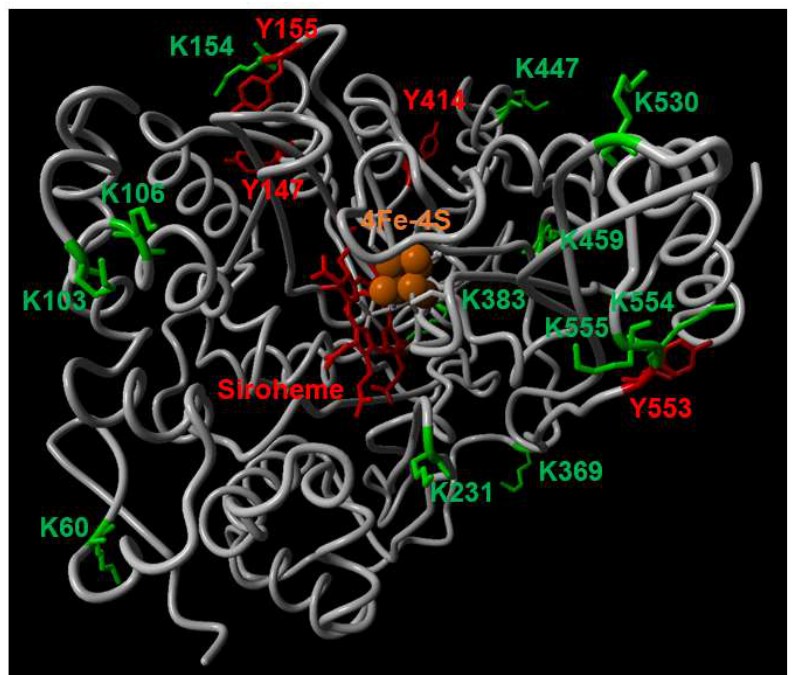
Figure 4. Location of identified PTMs in the 3D structure model of Spinacia oleracea NiR. Nitrated Y residues (red) and ubiquitylated K residues (green) location in the 3D structure of spinach NiR (2akj.pdb Protein Database Bank code) displayed in gray. Molecules of the 4Fe-4S cluster and siroheme are colored in orange and red, respectively.